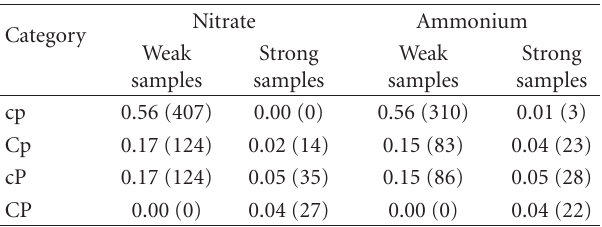
Table 3: Ratio of the number of samples in the categories low/high concentration (c/C) and low/high precipitation amount (p/P) to the number of all samples, calculated for both nitrate and ammonium. Values for weak and strong samples are shown separately. Values in brackets show the number of samples in each